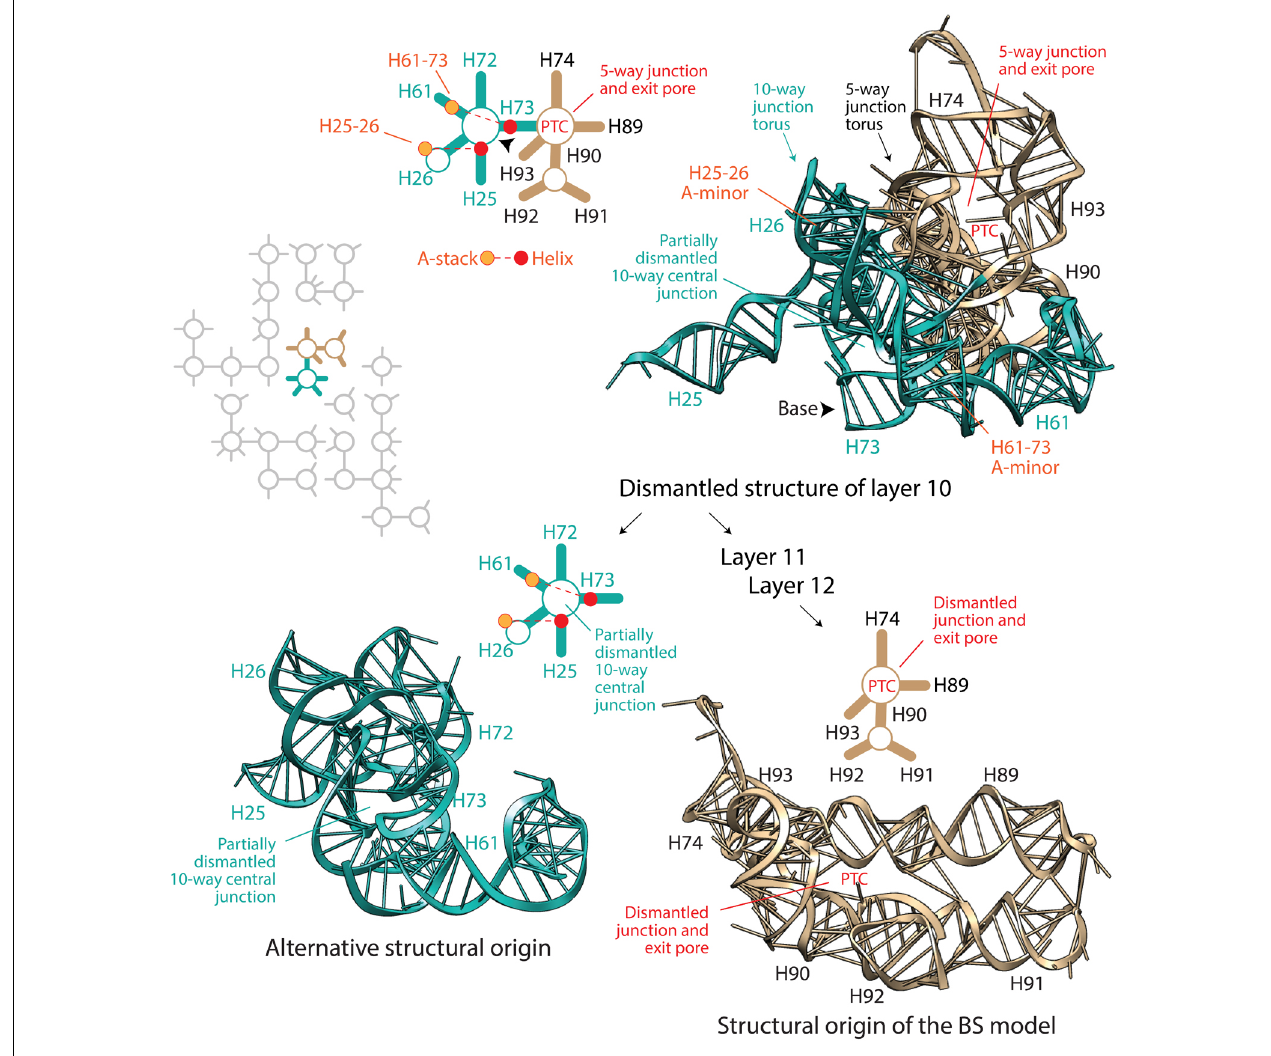
FIGURE 1 | Which dismantled structure is core? The BS algorithm dismantles the large subunit rRNA molecule in layers, working backward in time, from the most peripheral components (layer 1) toward the central peptidyl transferase canter (PTC). The diagram shows the dismantled structure of layer 10 and two possible points of origin derived from it (see Bokov and Steinberg, 2009). The flow diagram in the right describes the removal of substructures according to the BS model, which arrives to the tan-colored structural model of the PTC. In turn, dismantling the PTC results in one of many equally likely structural origins (not made explicit by Bokov and Steinberg, 2009), which is shown in the aqua-colored structure